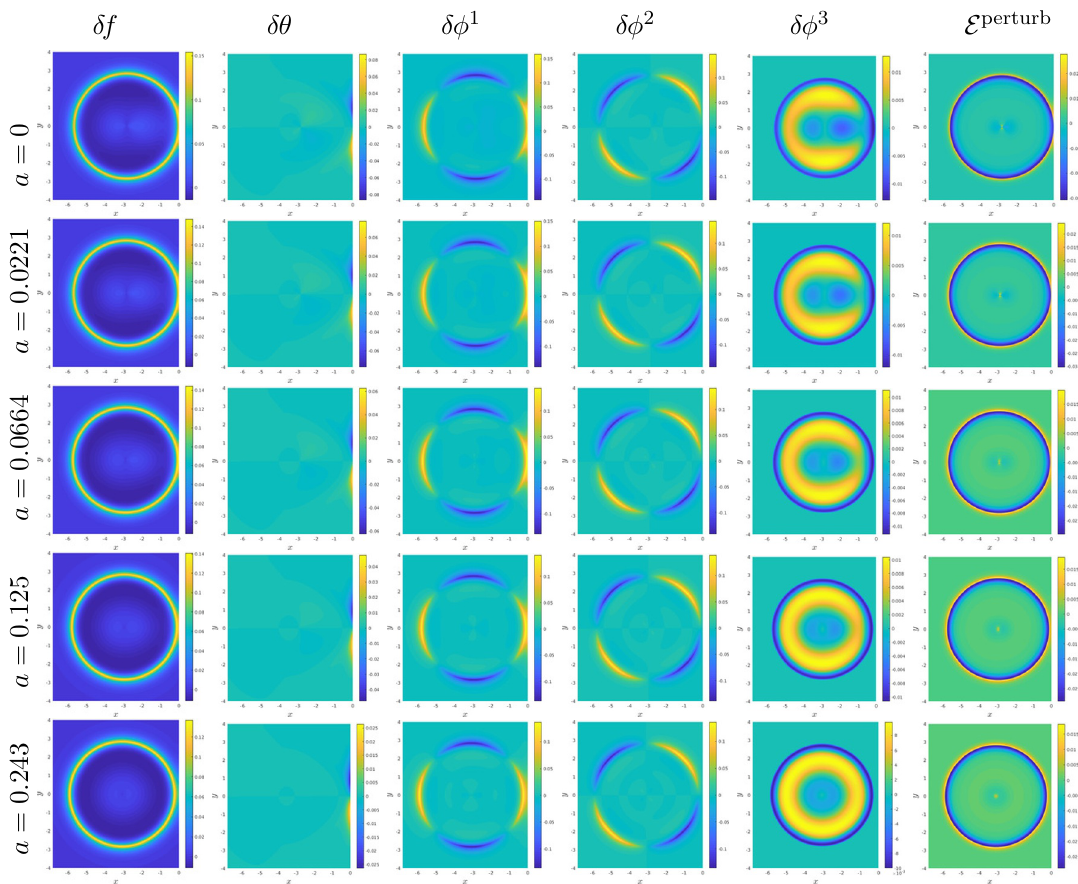
Figure 14 . Numerical solution for δf and δθ for two N = 2 compactons situated next two each other with separation distance 2 a for (cid:15) = 0 . 0428 . Due to symmetry of the problem, only the left- hand side is calculated and shown. The gluing conditions (5.9) are imposed at x = 0 , which is located at the right-most part of every panel. Each row displays the perturbations δf , δθ , δφ 1 , δφ 2 , δφ 3 and the energy density of the perturbation E perturb , each in its column. Each panel is cropped so as to render the content as clear as possible; the left, top and bottom border do not represent the size of the